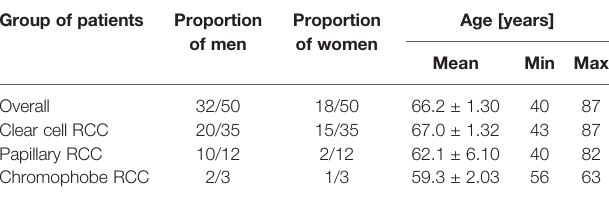
TABLE 1 | Characteristic of patients with clear cell, papillary and chromophobe